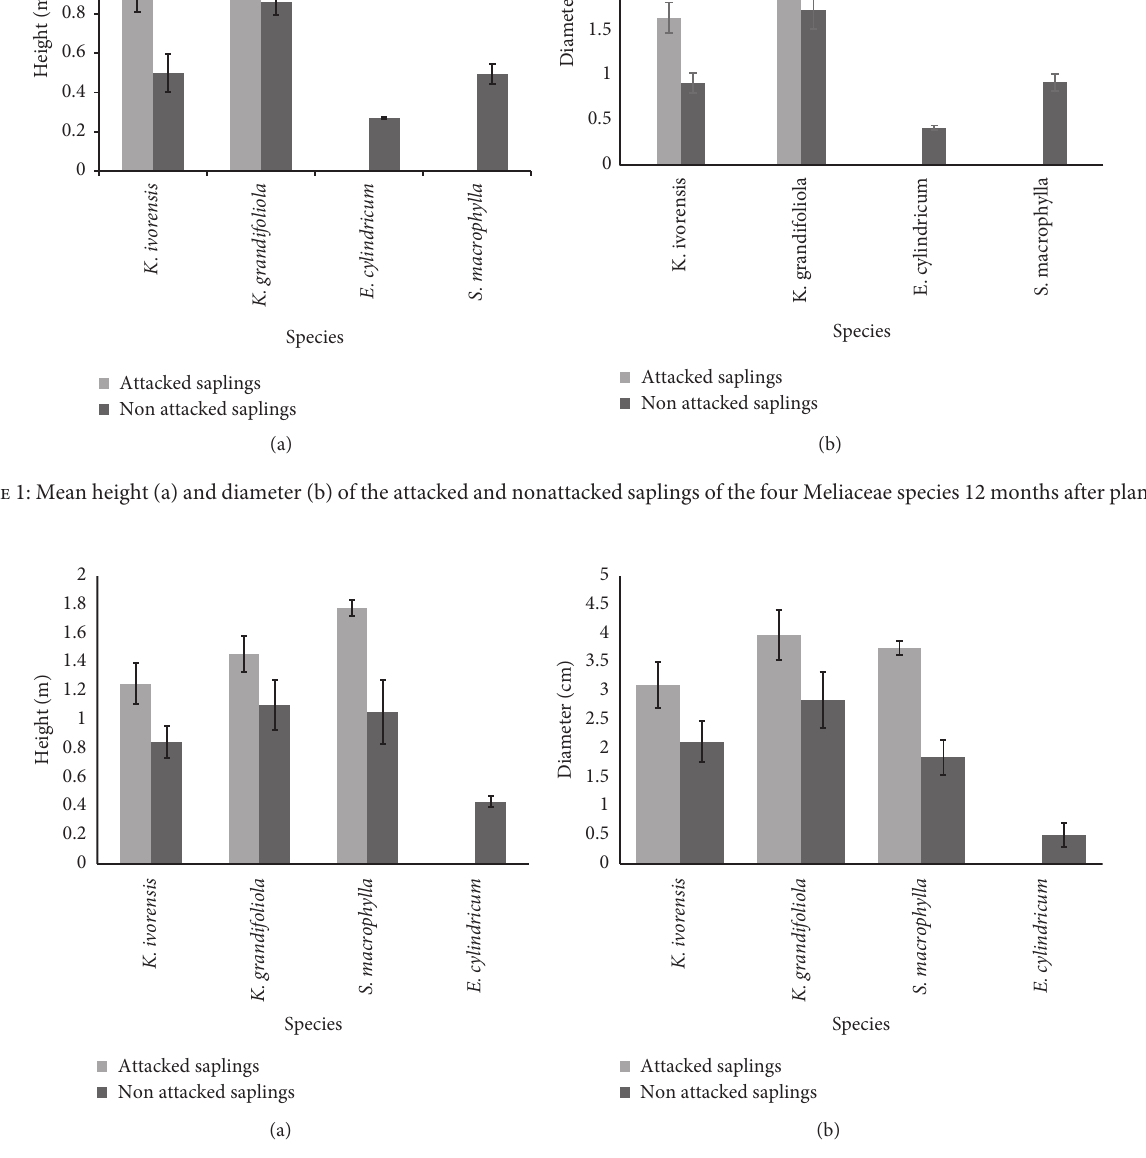
Figure 2: Mean height (a) and diameter (b) of the attacked and nonattacked saplings of the four Meliaceae species 21 months after planting.